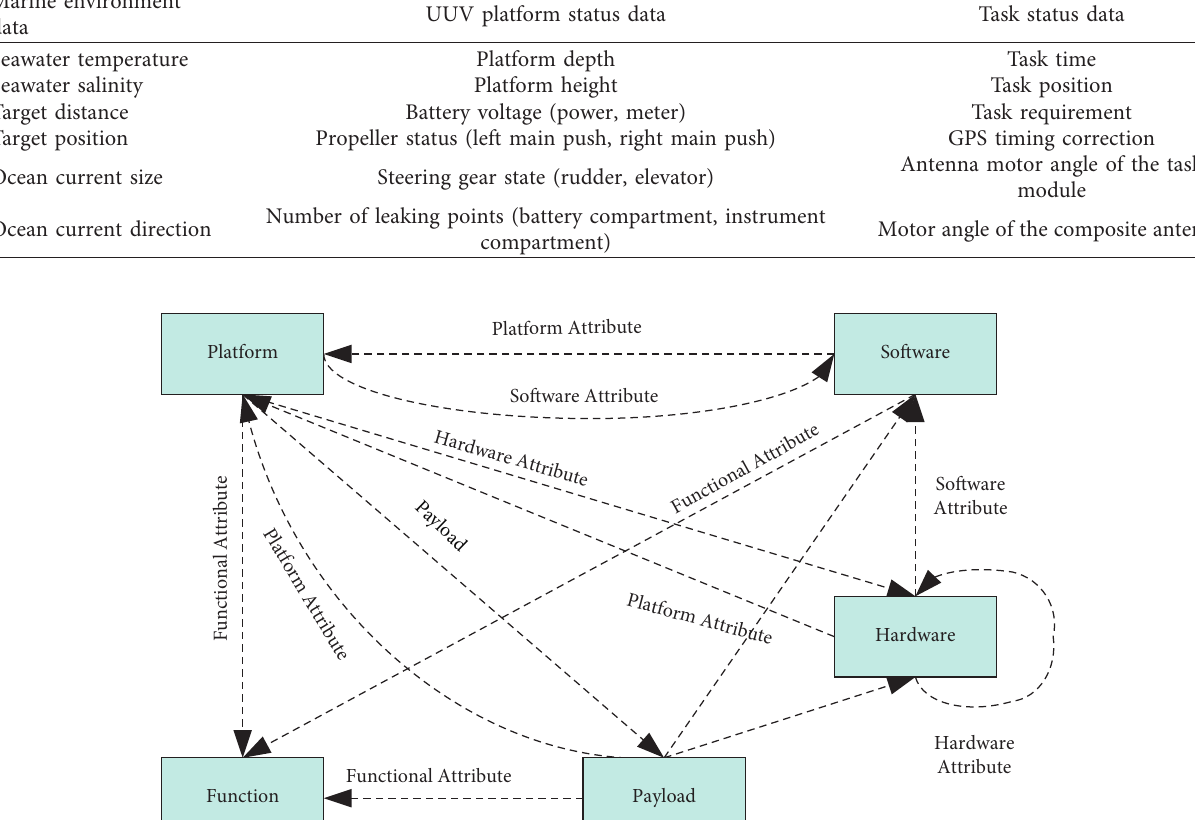
Figure 1: Core ontology of